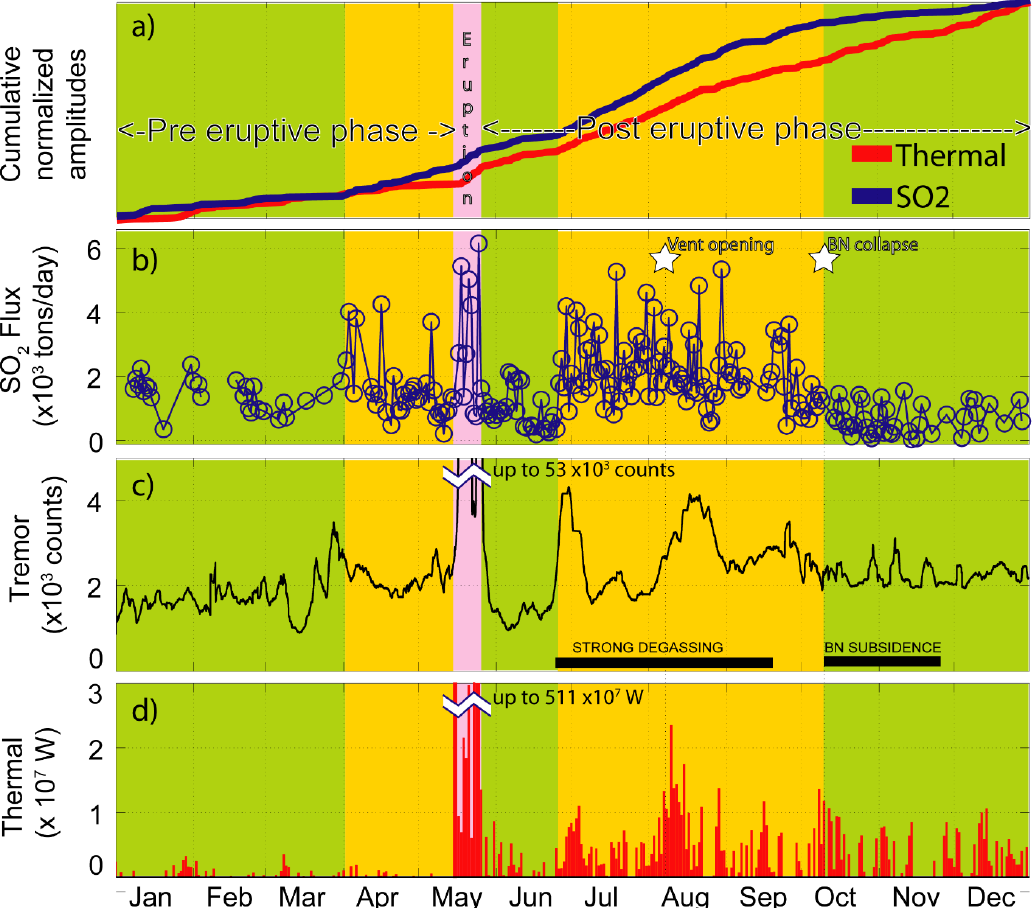
Figure 7. ( a ) Cumulative daily averaged SO 2 fluxes are compared with thermal cumulative activity detected by MIROVA. ( b ) SO 2 flux daily average time-series are compared with seismic tremor amplitude ( c ), and thermal radiance ( d ). Three volcanic degassing levels are distinguished by different colors: green, low average degassing, orange, enhanced degassing, pink: intense degassing. The May 2016 Eruptive phase is preceded by more than one month long period of enhanced degassing activity when no significant increase in tremor and thermal is identified. Enhanced degassing activity is also detected between July and September, according to relatively higher tremor and thermal signals.